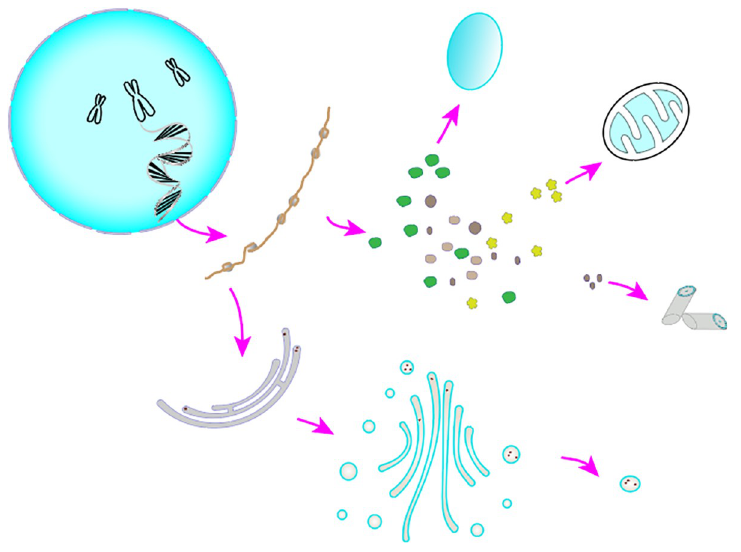
Fig 2. Cell synthesis protein.